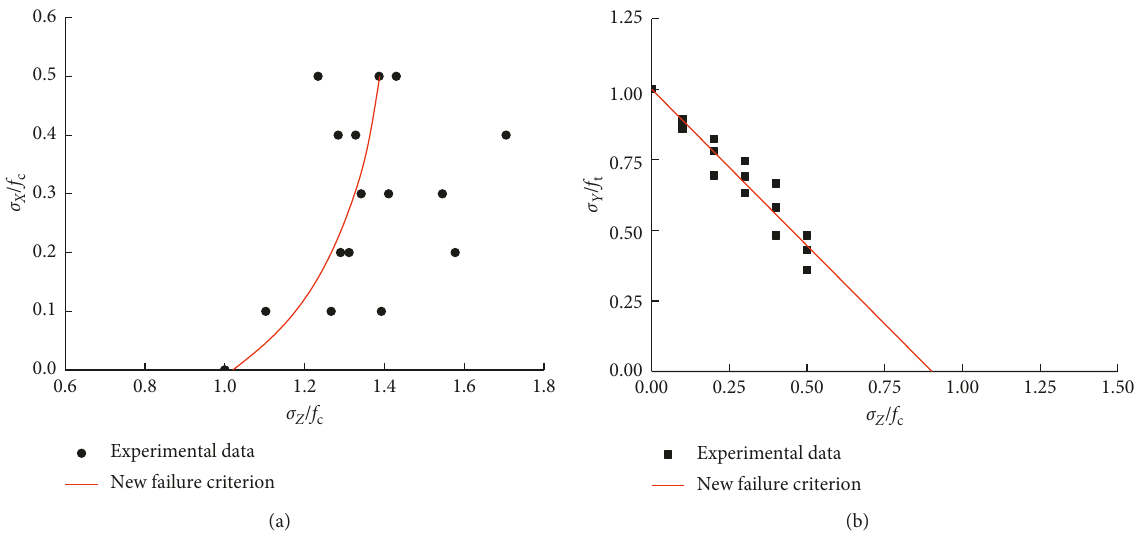
Figure 9: New failure criterion based on Kupfer’s failure criterion. (a) Biaxial compression-compression. (b) Biaxial compression-tension.